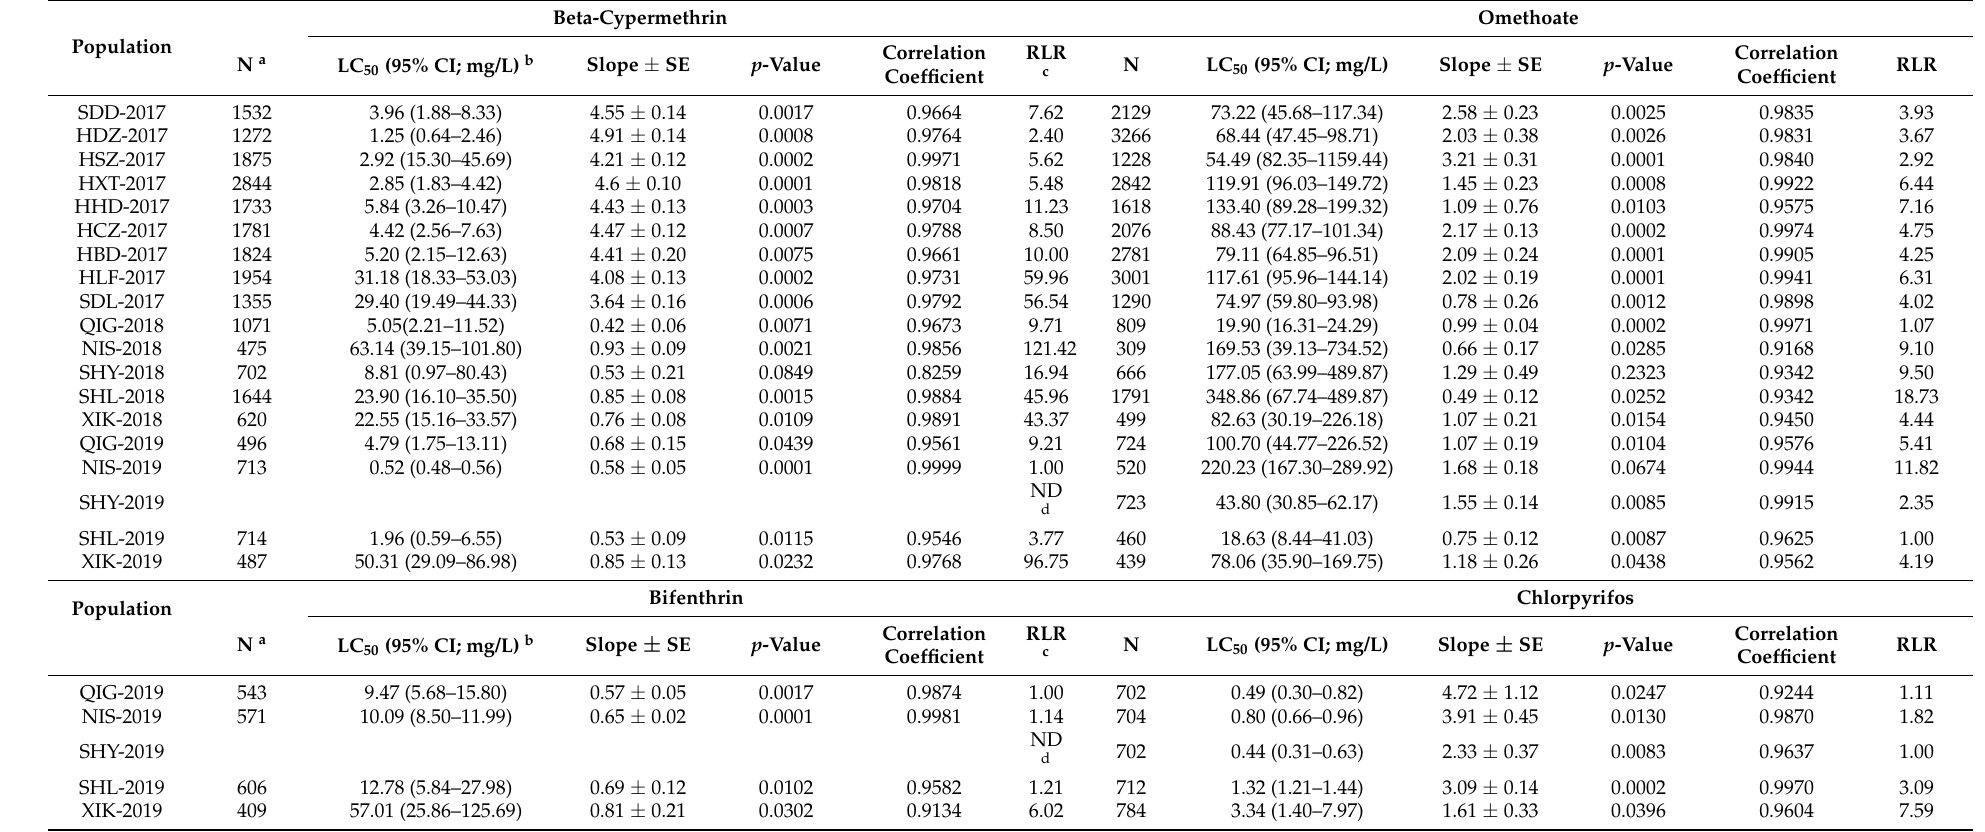
Table 4. Susceptibility of Metopolophium dirhodum field populations to beta-cypermethrin, bifenthrin, omethoate, and